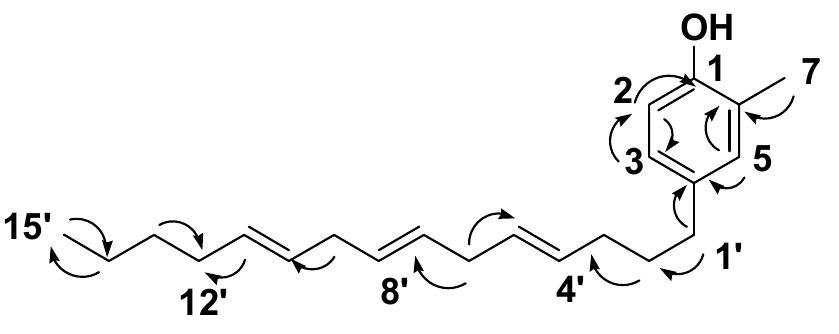
Figure 3. Selected heteronuclear multiple-bond correlation ( HMBC) ( ) correlations of compound 12.